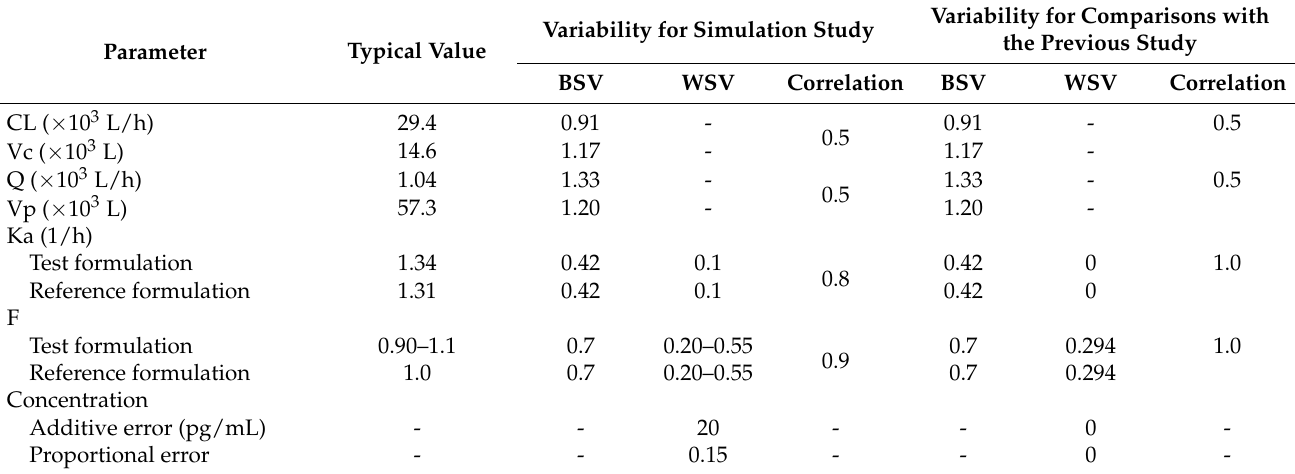
Table 1. Simulation parameters for the two-compartment pharmacokinetic